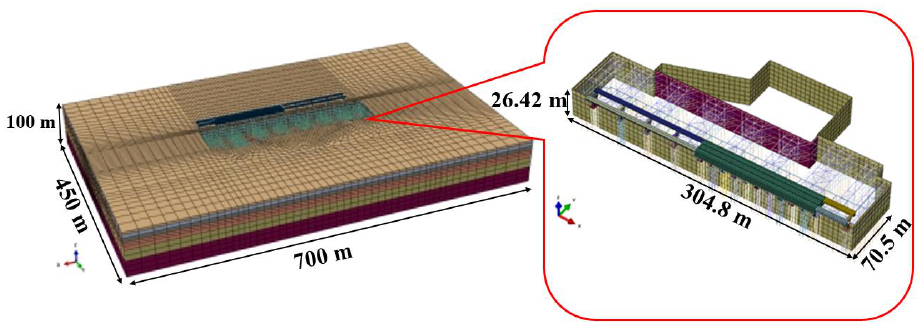
Figure 6. 3D finite element model.